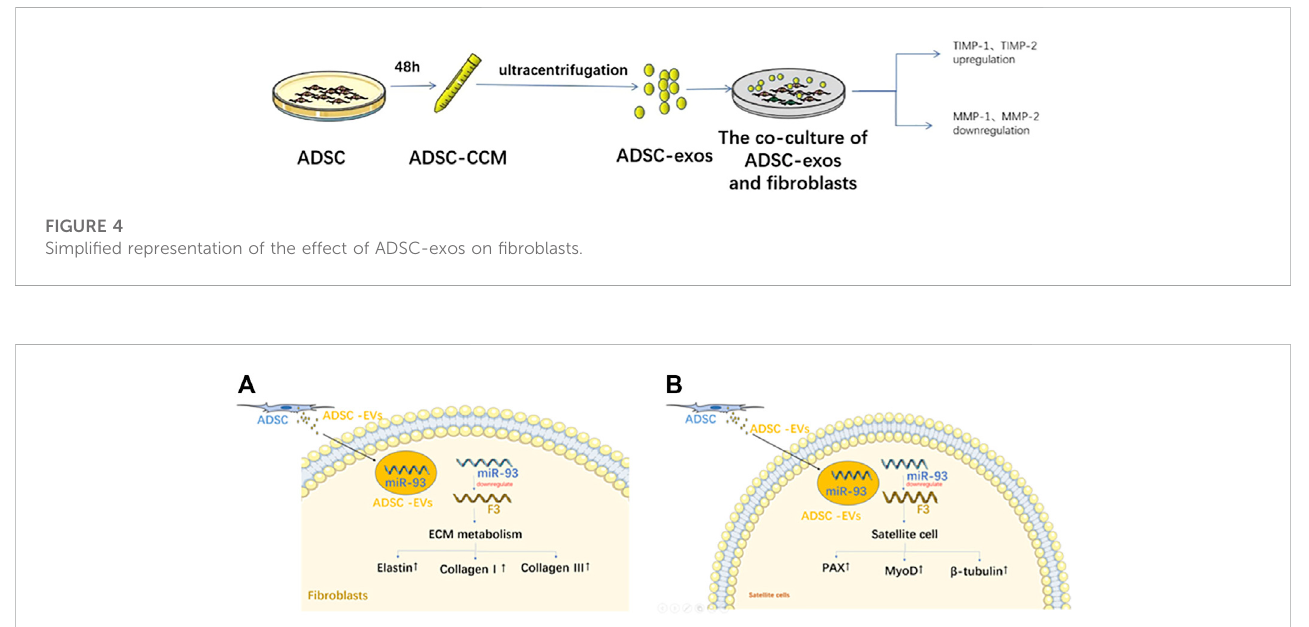
Frontiers in Cell and Developmental